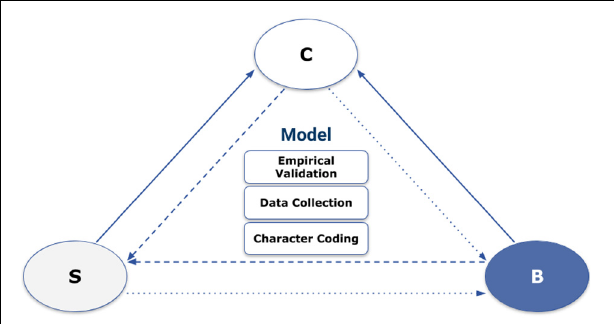
FIGURE 1 | The Character – Behavior – Situation (CBS) triad of Character Computing and the building blocks of achieving a psychologically driven computation model, namely empirical validation, data collection, and ontology-based character coding. This differentiates the use of the term character from its